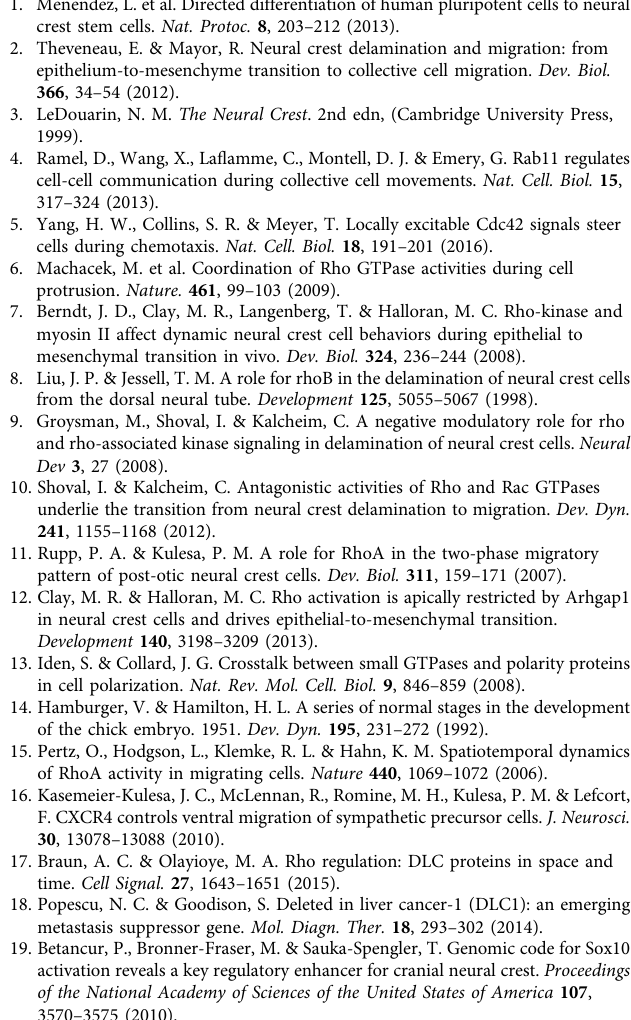
anti-SOX9, anti-SOX10 or control rabbit anti-IgG (Abcam). Samples were washed, eluted and reverse cross-linked. The precipitated DNA fragments were puri fi ed and